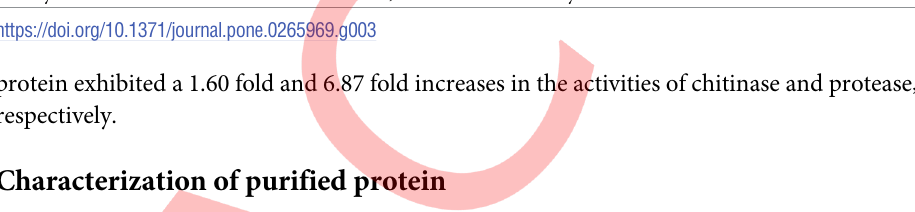
Fig 3. (A and B) Activity assay of recombinant bacteria having different constructs. A = PRI—Protease, FP- Protease activity in the fusion construct. B = CHI-chitinase, FCH-chitinase activity in fusion